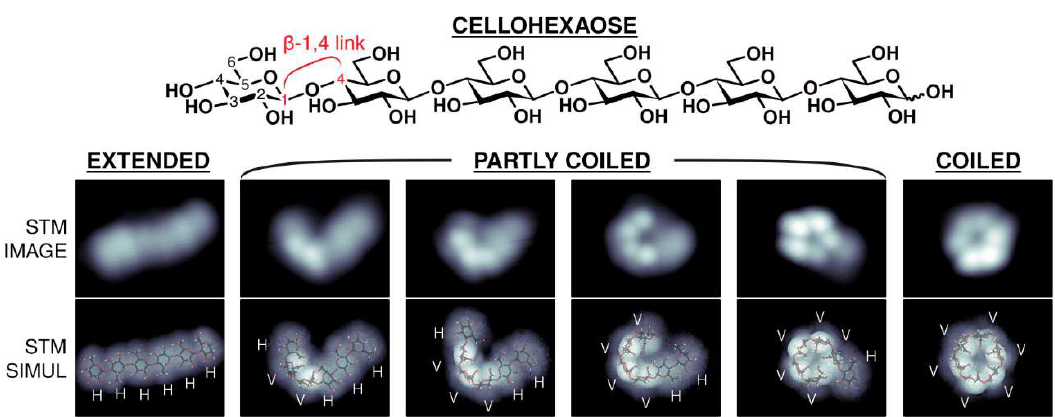
Figure 9. STM image and STM simulation of cellohexaose on Cu(100). The deposition parameters’ control permitted the transition conformers between “extended” and “coiled” forms of cellohexaose. Reprinted with permission from Ref. [105] . Copyright (2020), American Chemical Society.